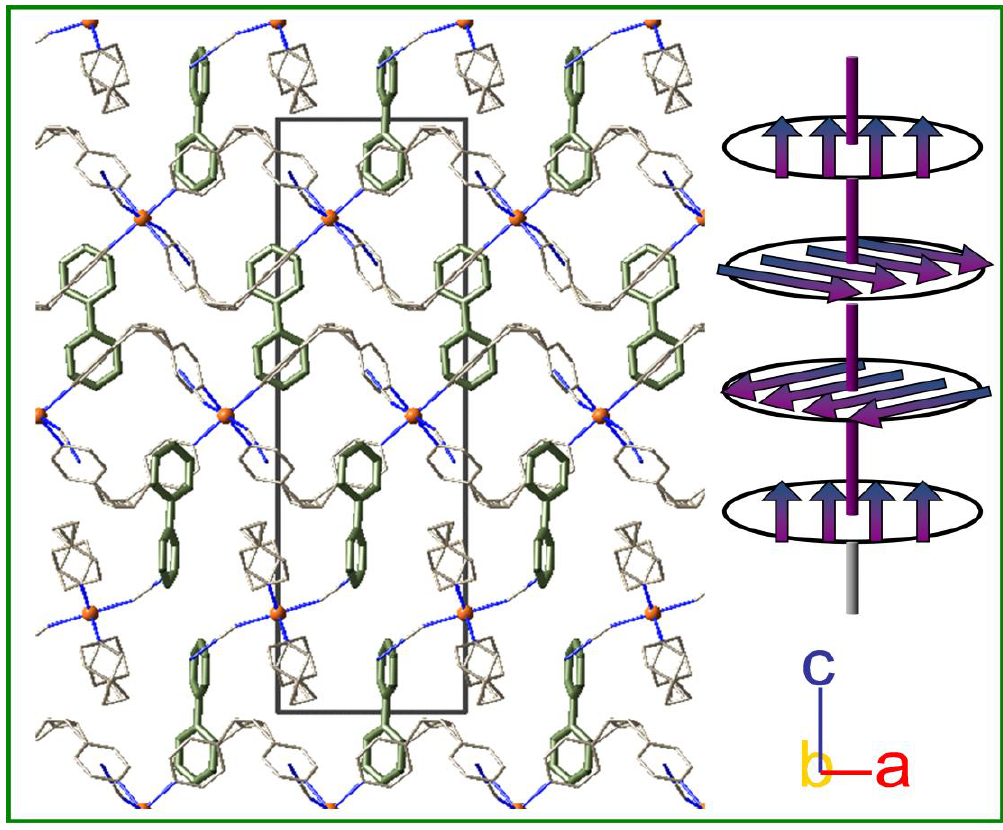
Figure 1. Packing view of spiral assembly at 298 K.